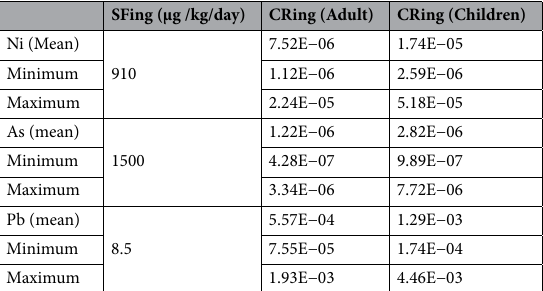
Table 11. Cancer risk associated with the levels of Ni, As and Pb in the drinking